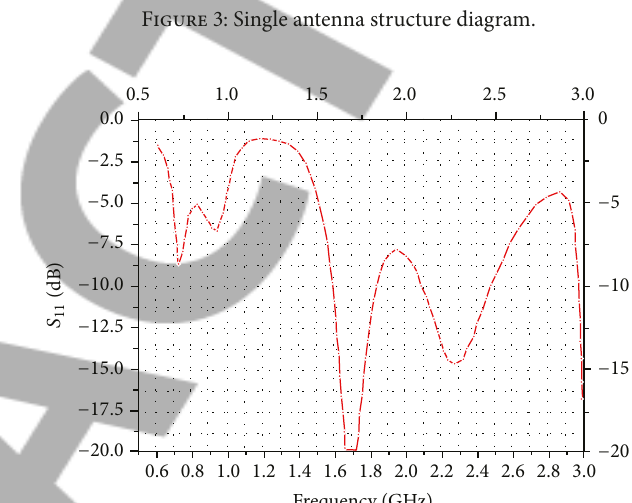
Figure 3: Single antenna structure diagram.